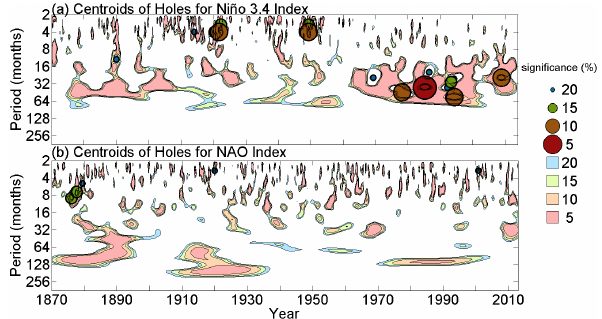
Figure 11. Same as Fig. 8c but for the mean monthly (a) Niño 3.4 and (b) NAO index anomalies for